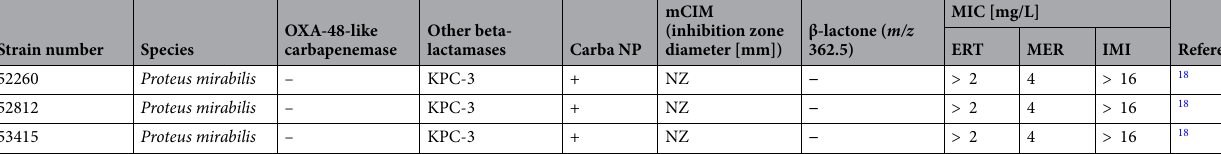
Table 1. Characteristics of bacterial isolates used in the study. NT not tested, NZ no inhibition zone detected, ERT ertapenem, MER meropenem, IMI